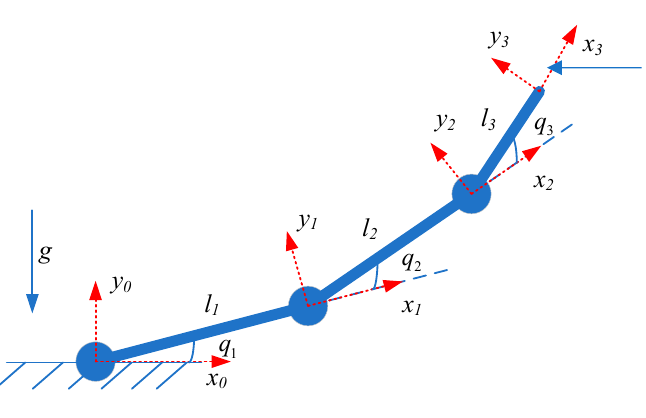
Figure 3. Structure of the 3-DOF manipulator. Table 1. Parameters of the 3-DOF planar manipulator.